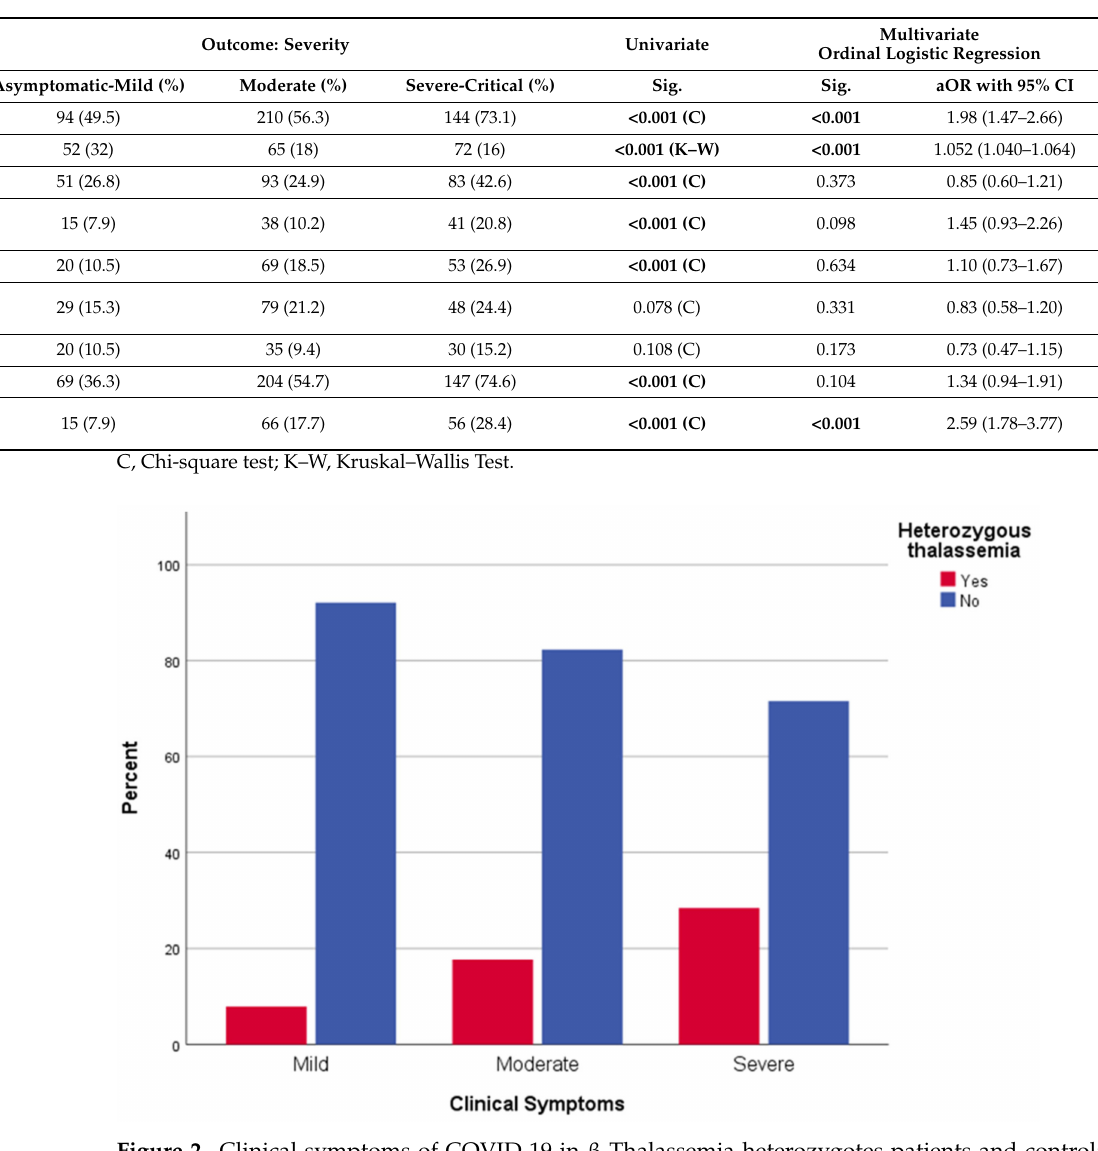
Table 2. Assessing clinical severity of COVID-19 by univariate and multivariate statistical analysis.